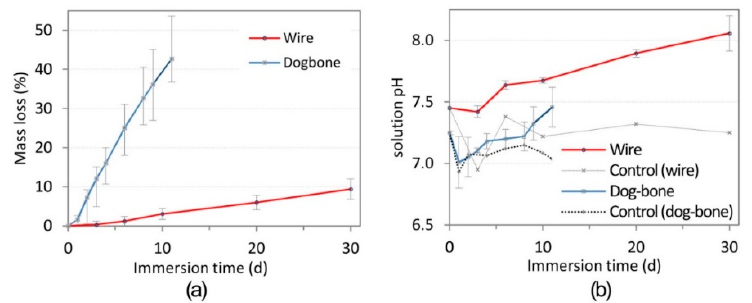
Figure 1. Plot of ( a ) percentage mass lost over time for dog-bone and wire specimens ( b ) evolution of SBF solution pH. Error bars represent 95% confidence intervals derived from T-table (n = 3).